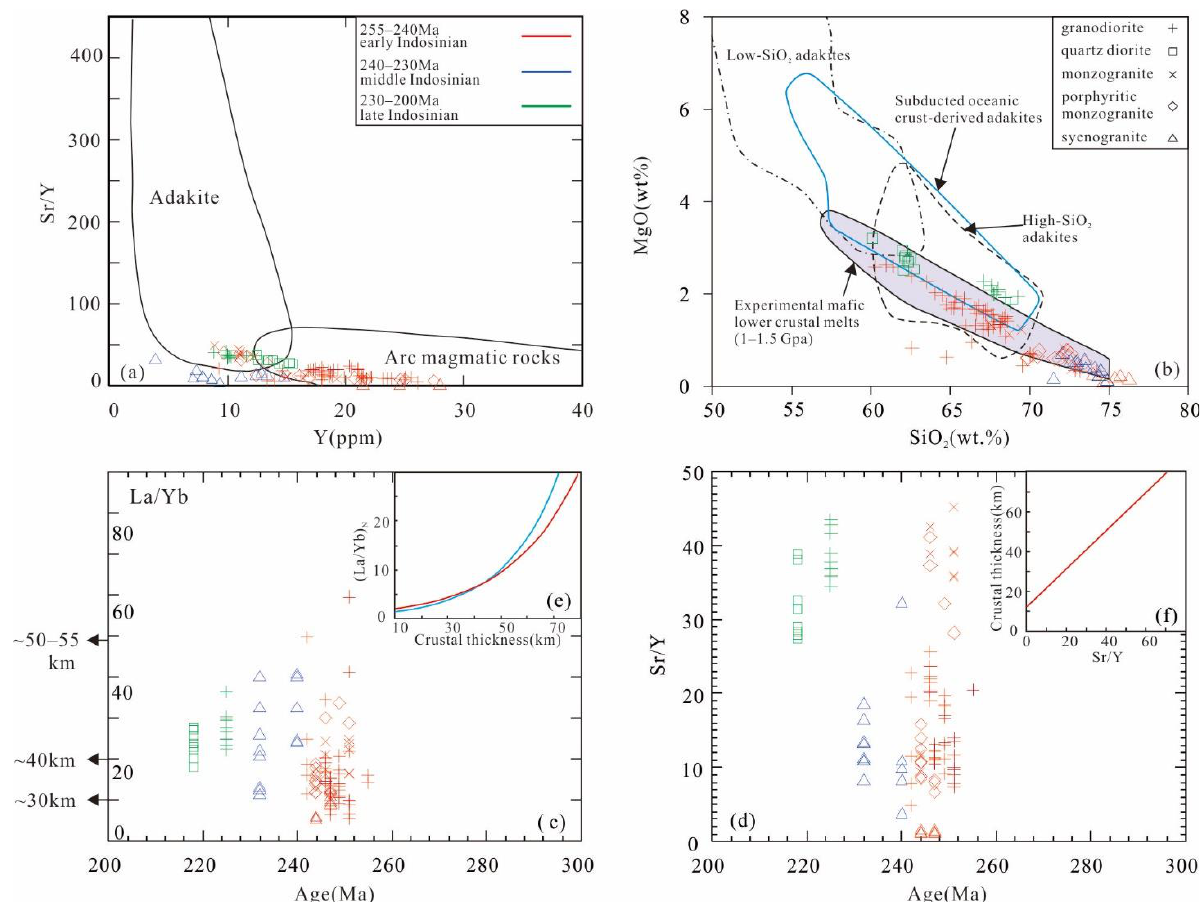
Figure 8. Diagrams of ( a ) Sr/Y vs. Y; ( b ) MgO vs. SiO 2 ; ( c ) La/Yb vs. ages; and ( d ) Sr/Y vs. ages for the granite plutons in the eastern region of the EKO during the Indosinian (a after [69]; b after [69]); ( e ) Diagram of (La/Yb) N vs. crustal thickness (after [73]); ( f ) Crustal thickness vs. Sr/Y (after [73]).